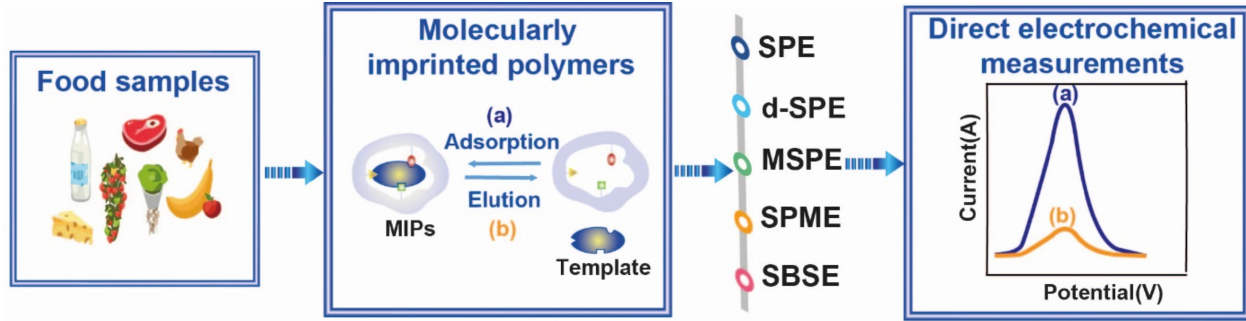
Figure 5. Application of MIP in sample preparation for the electrochemical analysis of food. SPE: Solid-phase extraction, d -SPE: Dispersive SPE, M-SPE: Magnetic SPE, SPME: Stir-bar sorptive extraction, SBSE: Solid-phase